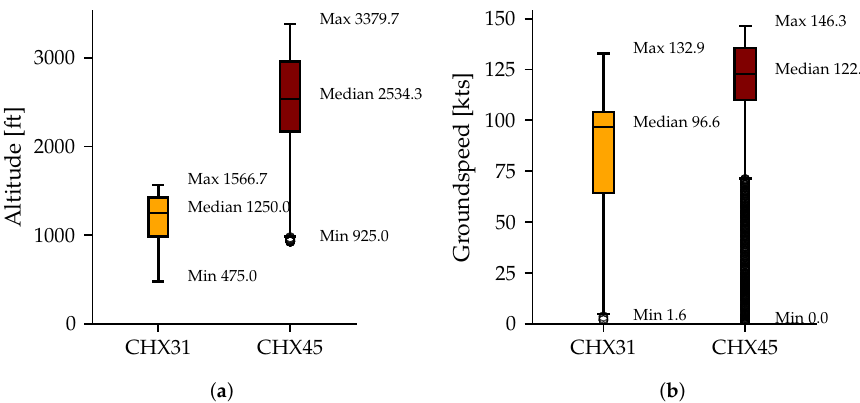
Figure 10. Boxplots and statistic of the chosen subset of flights for ( a ) altitude and ( b ) groundspeed.